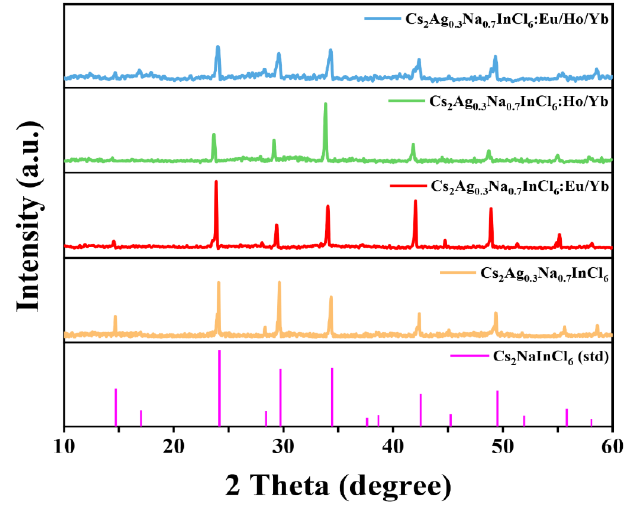
Figure 2. XRD patterns of Cs 2 Ag 0.3 Na 0.7 InCl 6 : Yb 3+ /Eu 3+ /Ho 3+ MCs and the standard XRD pattern of Cs 2 NaInCl 6 . The molar ratios of Yb:In, Eu:In, and Ho:In are 1:1, 1:1, and 0.6:1, respectively.